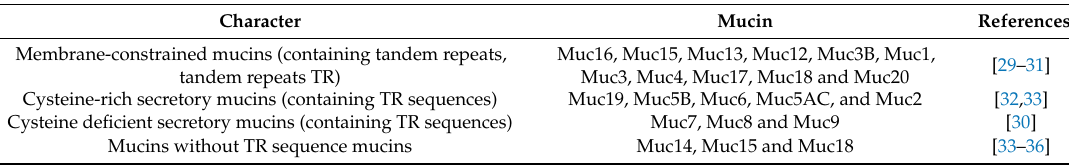
Table 1. Mucin-type classification.